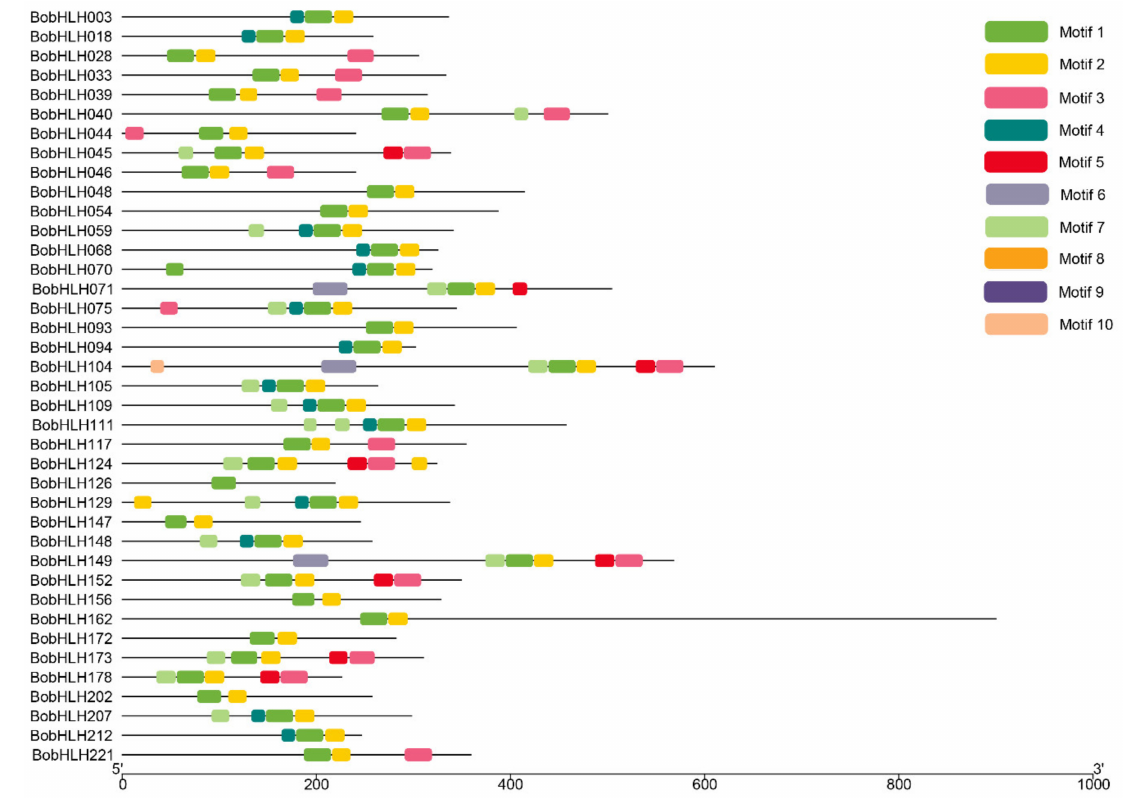
Figure 5. Chilling-responsive BobHLH protein motifs. The motifs are shown as colored boxes. The scale on the bottom may be used to estimate the length of the motif (unit: amino acid). The motifs in each BobHLH protein are in Figure